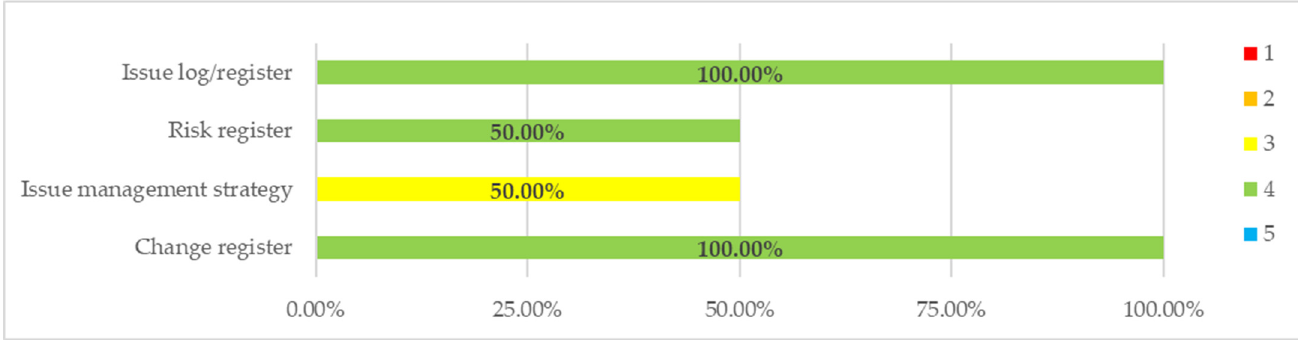
Figure 13. Evaluation of the effectiveness of the methods, techniques and tools used for the issue control process. Source: own elab.